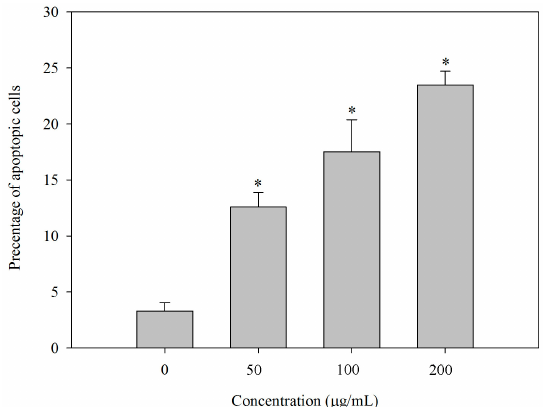
Figure 7. Apoptotic rate (%) of human hepatocellular carcinoma HepG2 cells treated with polysaccharide BEPS-IA. Cells were cultured for 24 h with BEPS-IA (50, 100 and 200 g/mL, respectively). Untreated cells (0 g/mL) were used as control. Values marked with * are significantly different compared to the control ( p < 0.05).